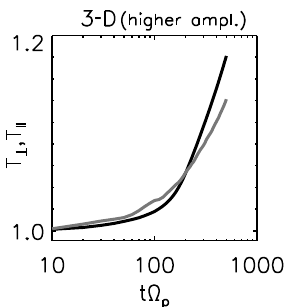
Figure 7. Time evolution of the perpendicular (black) and parallel (gray) temperature of the protons for the 3-D setup using higher driving amplitude